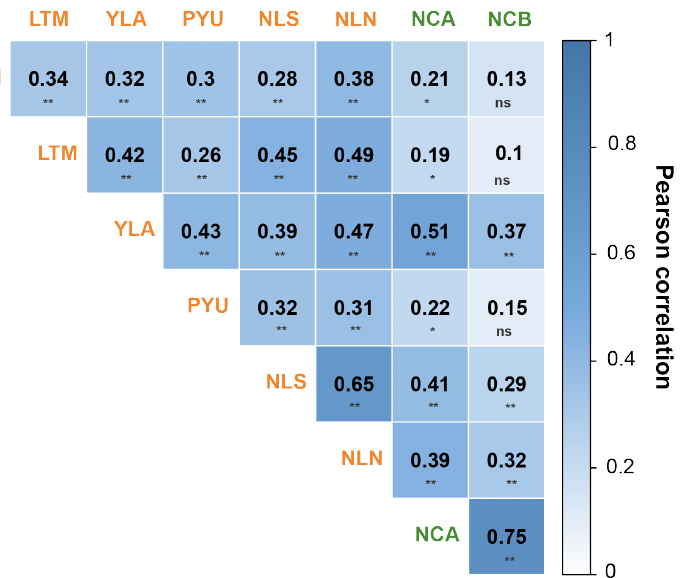
Figure 3. Pearson correlation coefficients between Nothofagus standardized ring-width index (RWI) chronologies from sampling locations in SSA over 1895–2019, the interval showing EPS > 0.85 in all records. N. pumilio and N. betuloides chronologies are shown with orange and green colors, respectively. Levels of significance are illustrated by ns: not significant ( p > 0.05), *: significant ( p < 0.05) and **: highly significant ( p <